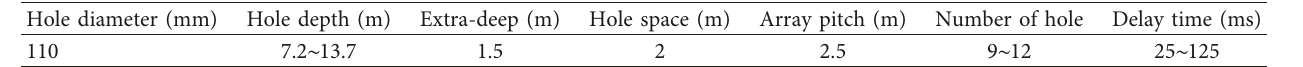
Figure 1: Project location and site photos. Table 3: Detailed blasting design parameters.